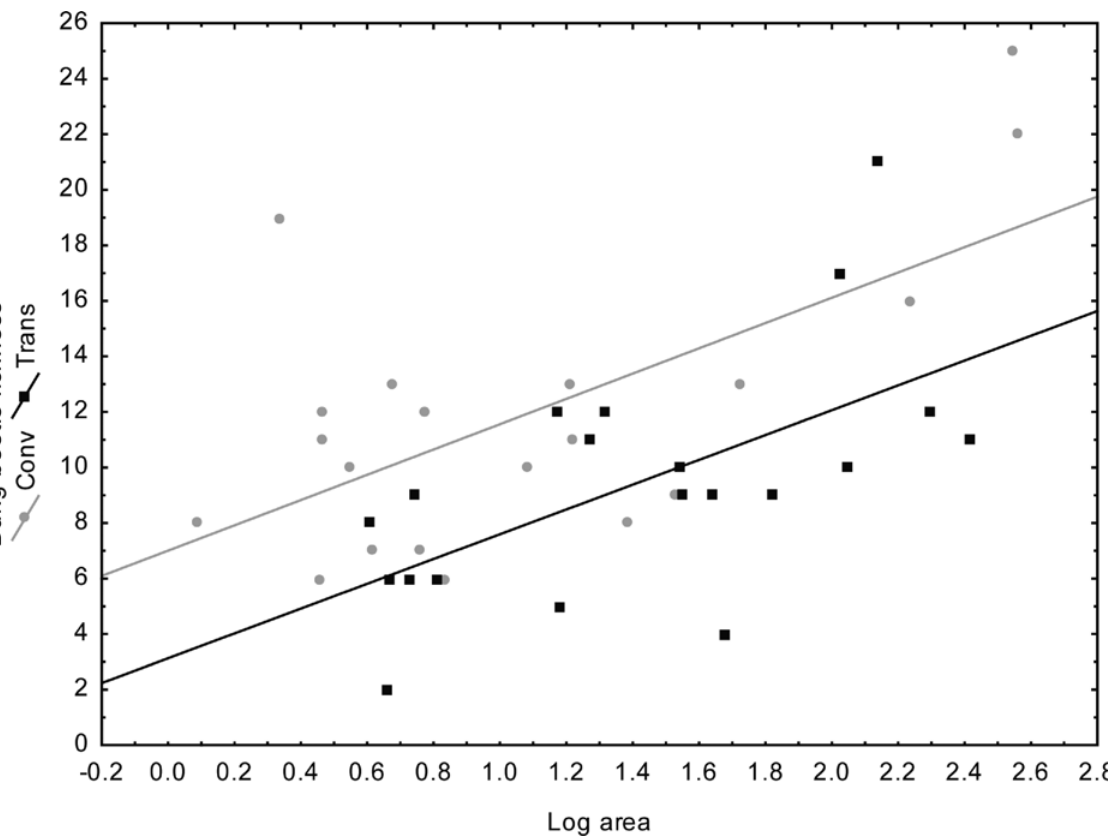
Fig 2. Dung beetle species richness in relation to fragment size (log area) in 40 Atlantic Forest fragments adjacent to transgenic and conventional maize in Campos Novos, Southern